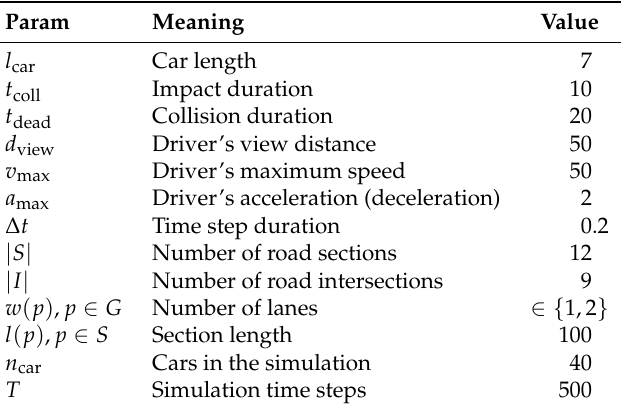
Figure 3. The road graph used in the experiments. Table 1. Model and simulation